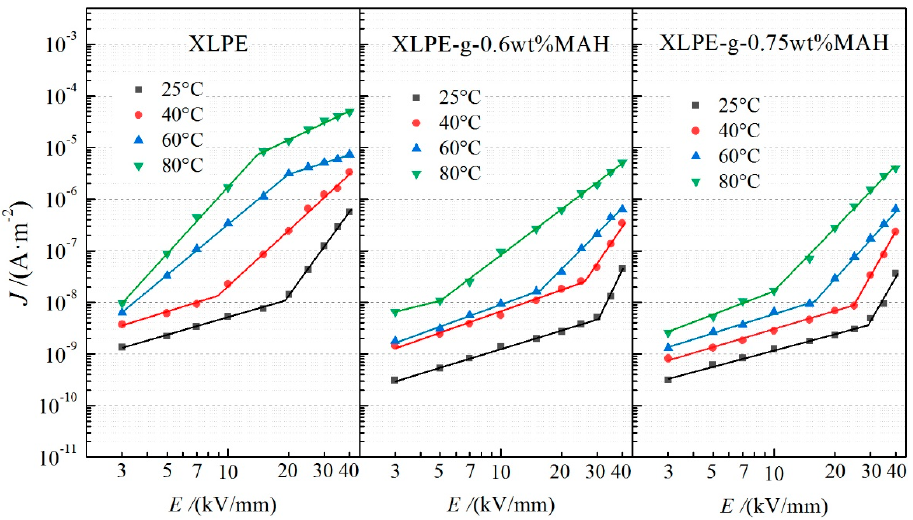
Figure 2. Conductivity properties of J – E varying curves for XLPE, XLPE-g-0.6 wt %MAH and XLPE-g-0.75 wt %MAH at the individual temperatures from 25 °C to 80 °C.